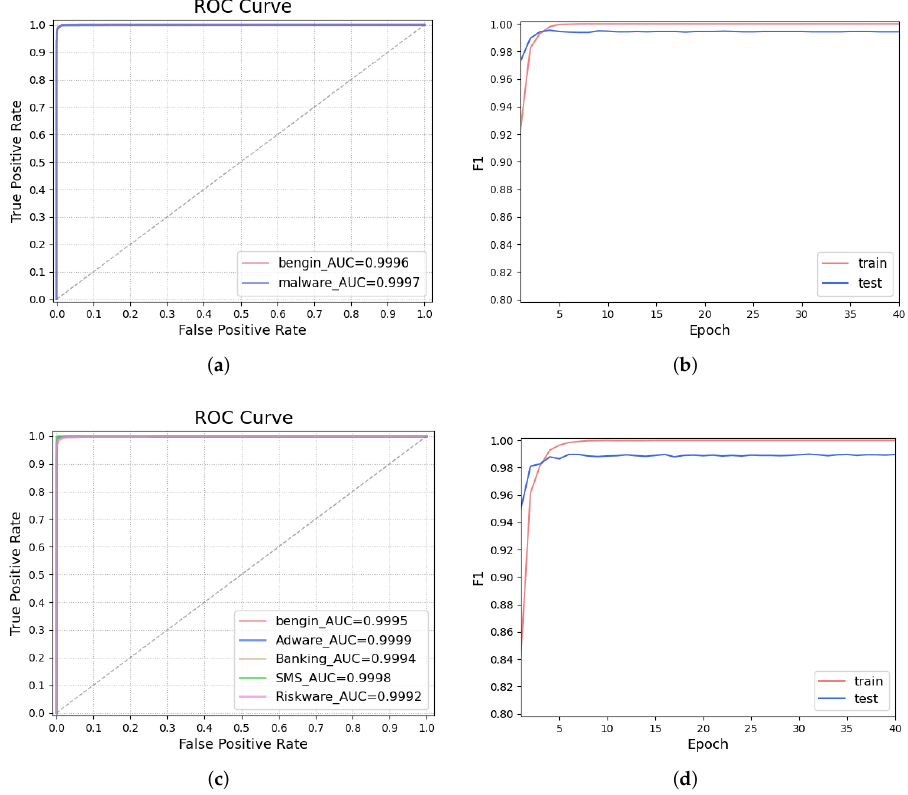
Figure 9. ( a , c ) ROC/AUC diagrams for detection and classification tasks; ( b , d ) F1 scores for detection and classification tasks. Table 3. Malware detection and classification results Classification